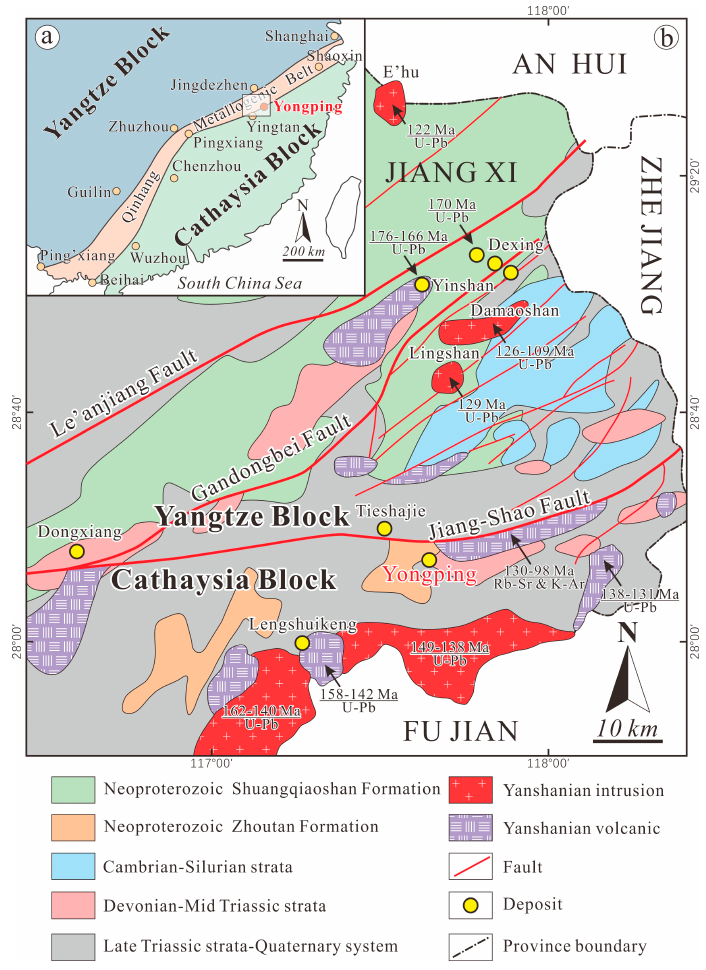
Figure 1. Regional geology of the northeastern Jiangxi district and the location of the Yongping Cu deposit (modified after [27]).